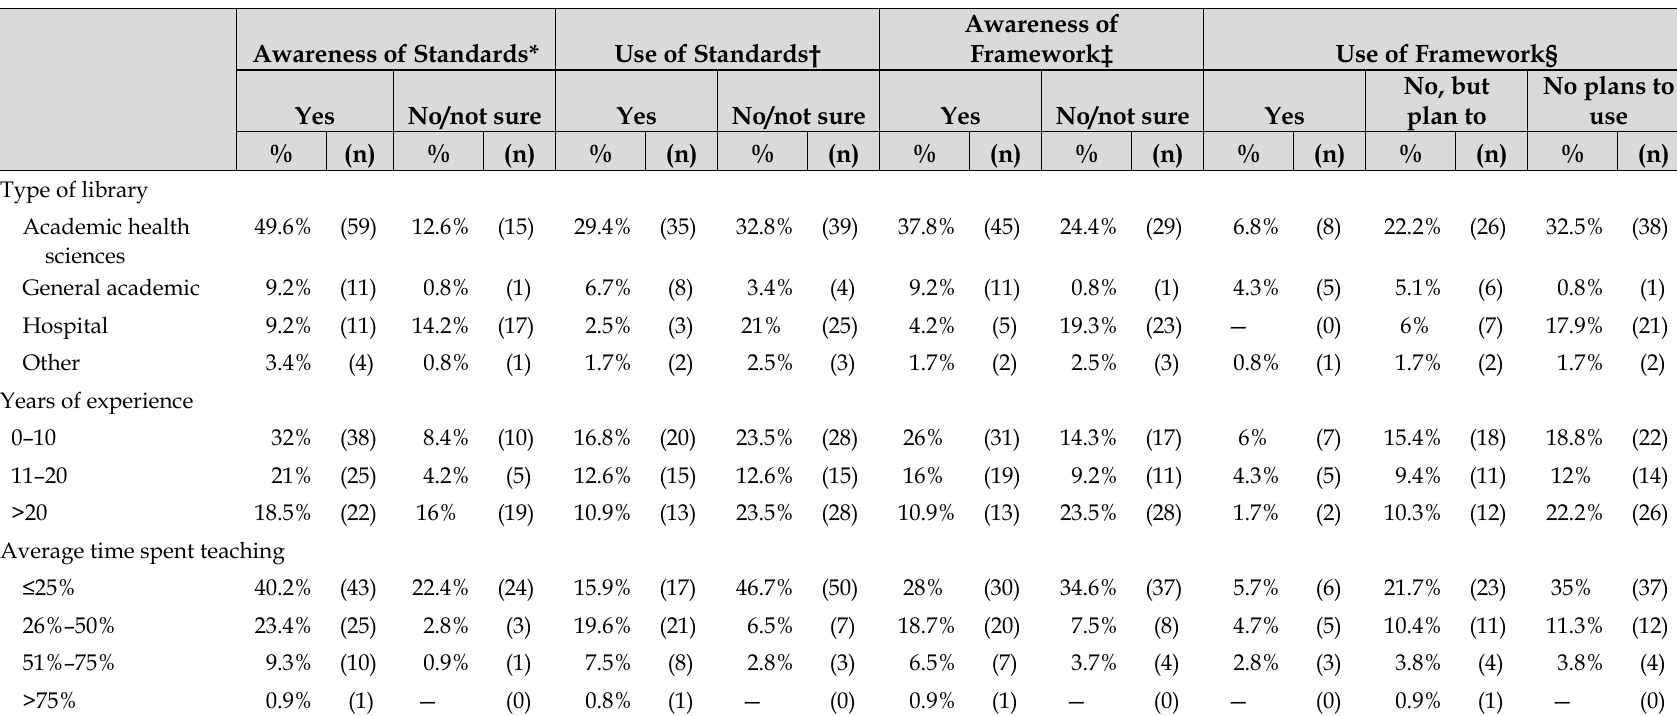
Table 2 Relationship between awareness and use of the ACRL Standards and Framework to type of library, years of experience, and time dedicated to teaching Awareness of Standards* Use of